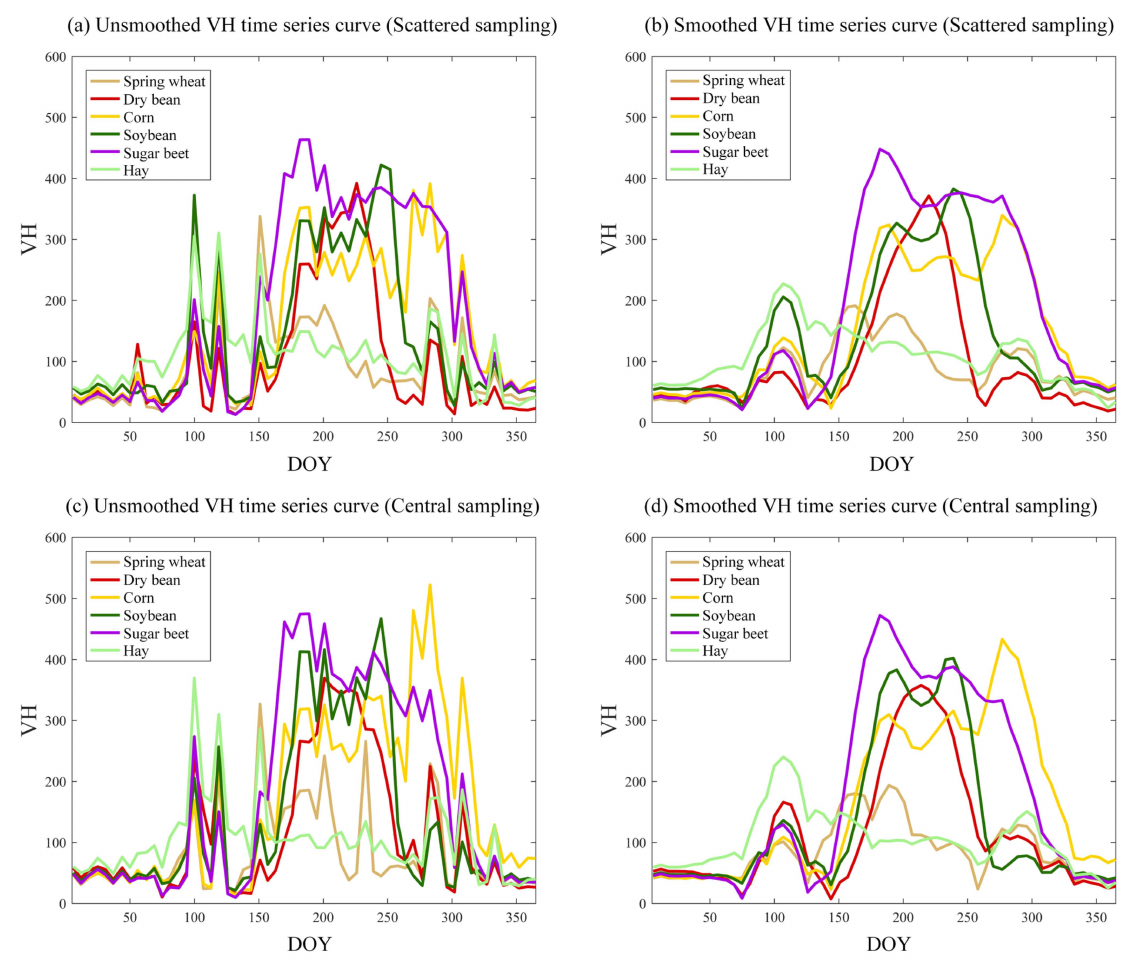
Figure 4. Mean values of VH time series curves for different crop training samples: the original ( a ) and SG filter curves ( b ) of scattered samples, and the original ( c ) and SG filter curves ( d ) of central